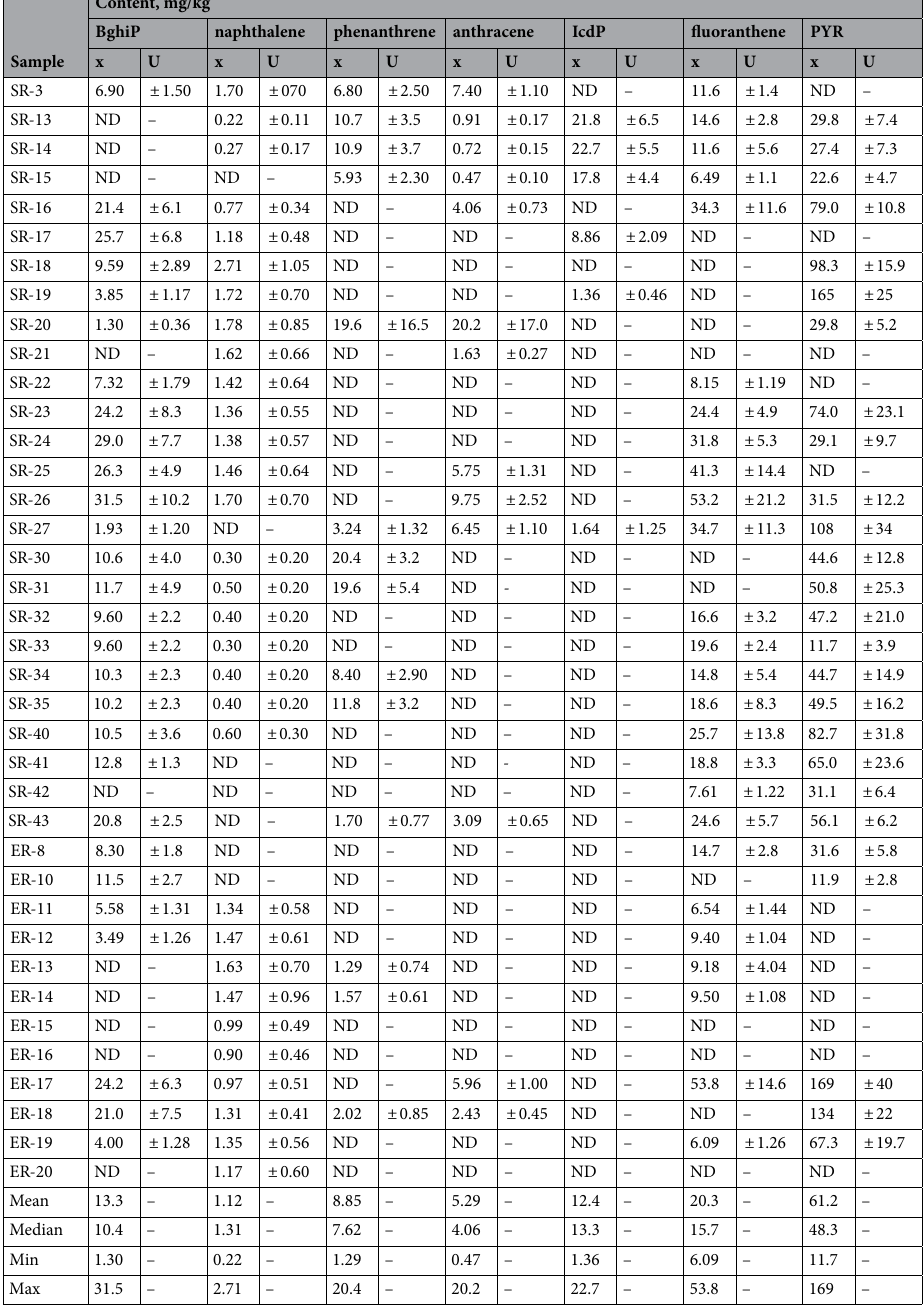
Table 5. The content of BghiP, naphthalene, phenanthrene, anthracene, IcdP, fluoranthene and PYR in rubber granules. ND not